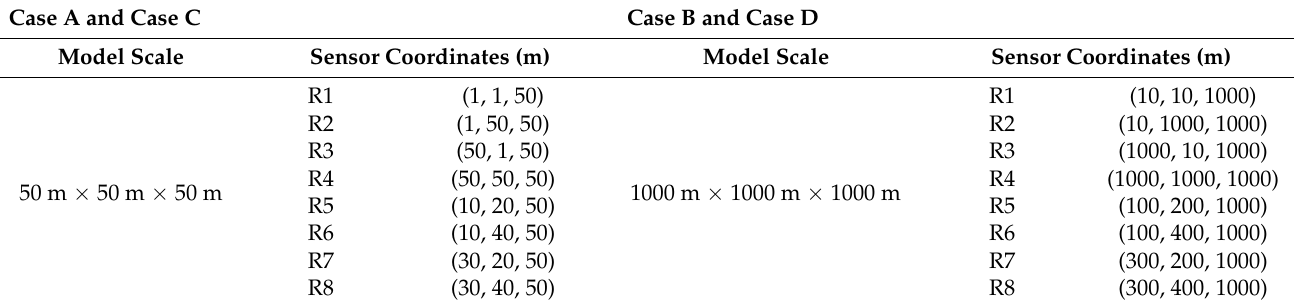
Table 1. The cases of microseismic velocity models, including model scale size and sensor coordinates. Case A and Case C Case B and Case D Model